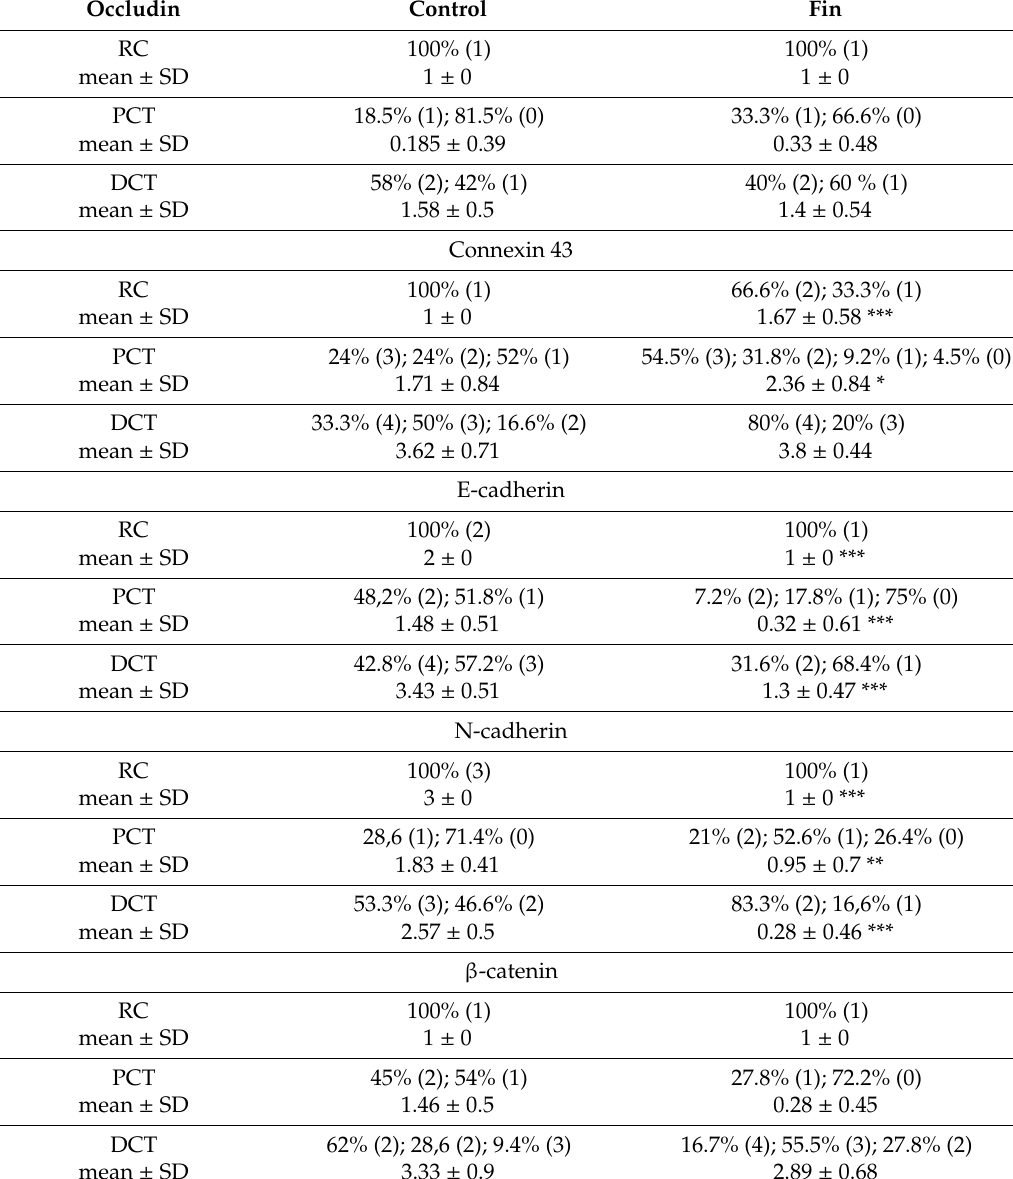
Table 3. The percentage of evaluated portions of nephron (RC, PCT, and DCT) according to the level (0–4) of expression of intercellular junction proteins in control and finasteride-treated rats